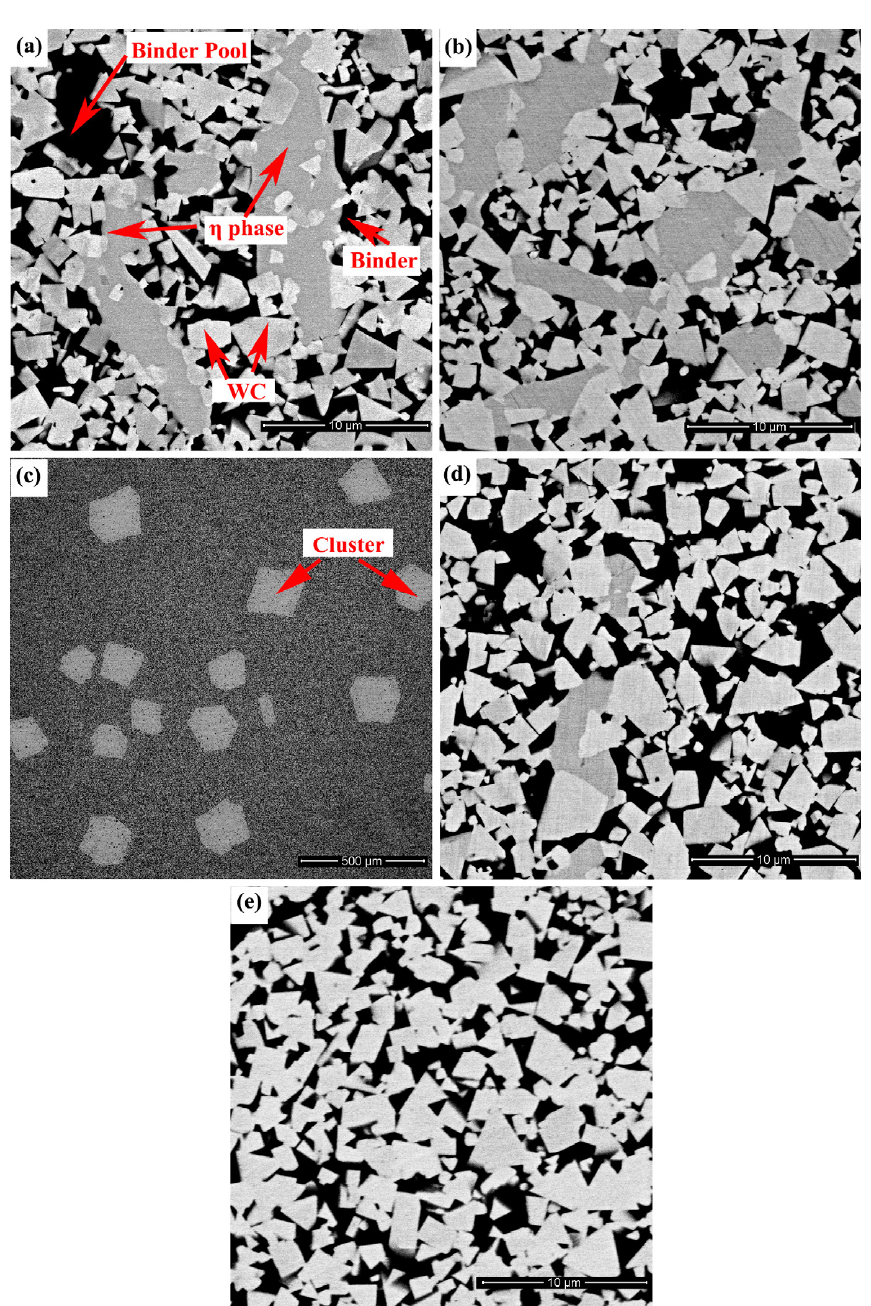
Figure 4. Microstructure of WC-10Co-7Ni-2Fe-1Cr: ( a ) Alloy A, ( b ) Alloy B, ( c ) Alloy C, ( d ) Alloy D and ( e ) Alloy E.